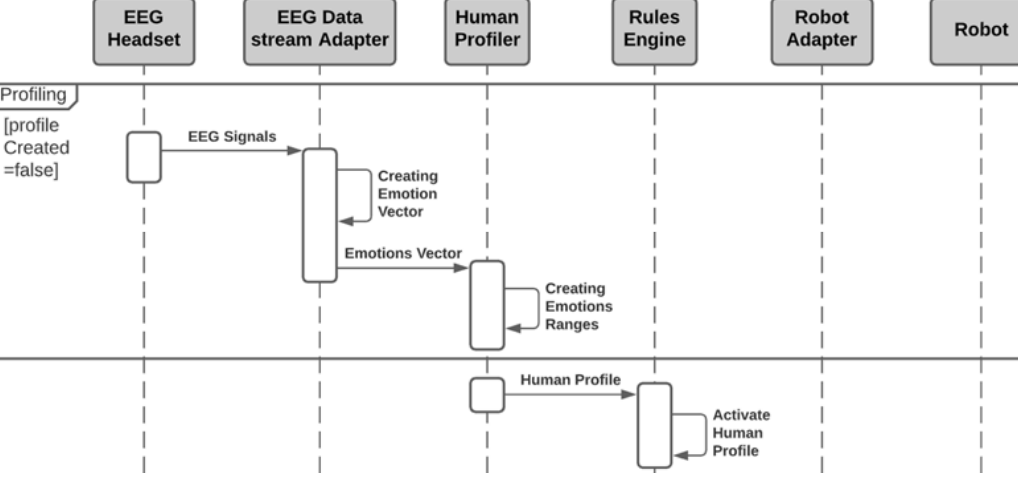
Figure 3. Sequence diagram of the human profiling process.